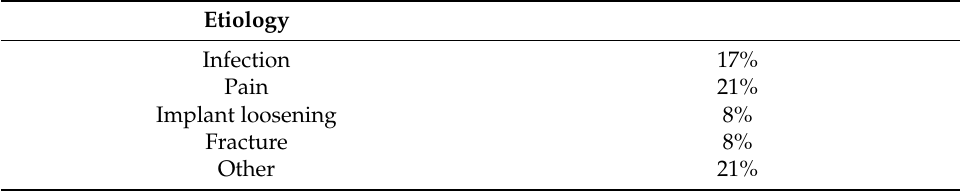
Table 2. Etiology for single-stage revision procedures.